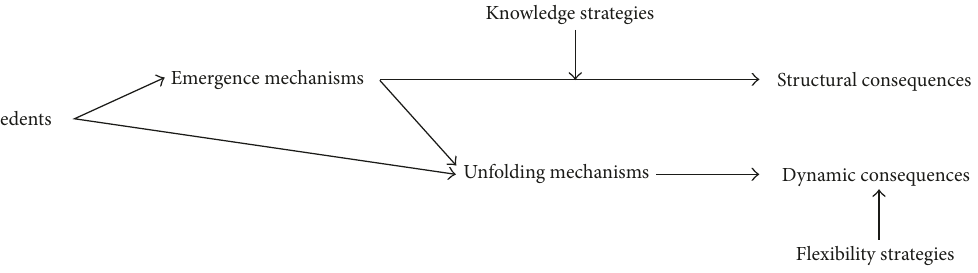
Figure 2: Integrative model of complexity influences and strategies for diminishing